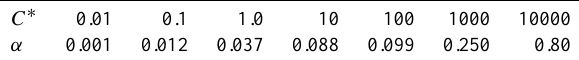
Table 1. Saturation concentrations C ∗ (µgm − 3 ) and corresponding stoichiometric coefficients α for VBS